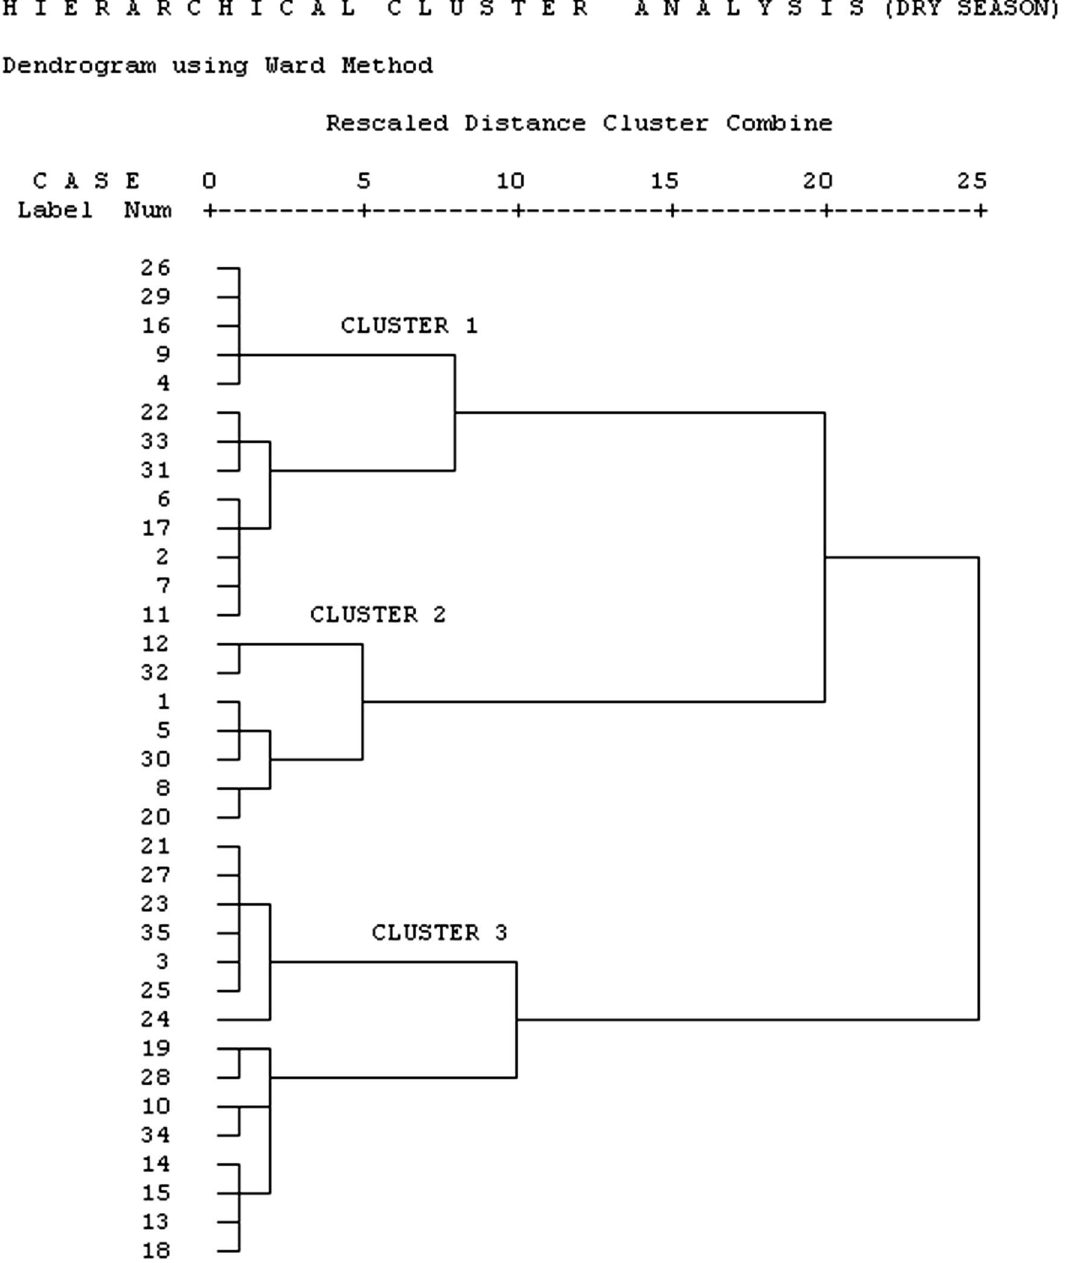
Fig. 10 Dendrogram of hierarchical cluster analysis of the SW sources in the dry